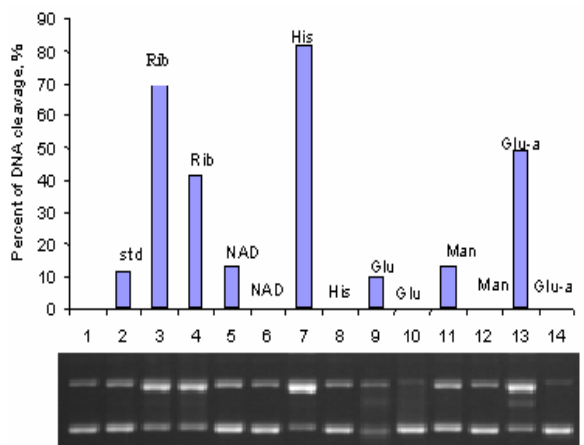
F igure 2 : Effect of biologically relevant molecules on